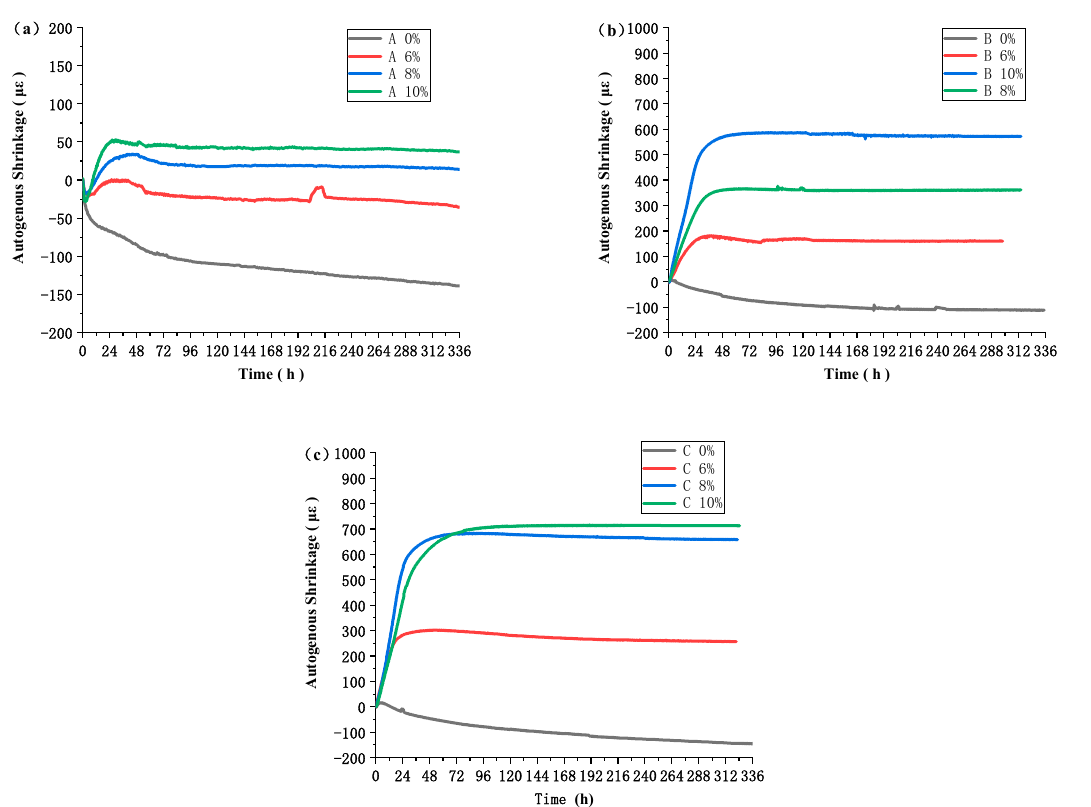
Figure 7. Effect of MEA content on early autogenous deformation of concrete at different temper- ature conditions. ( a ) Autogenous deformation at temperature A; ( b ) Autogenous deformation at temperature B; ( c ) Autogenous deformation at temperature